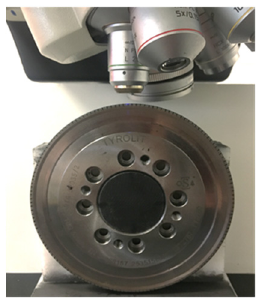
Figure 4. Initial characterization of the geometry of the rotary dresser on the confocal microscope.